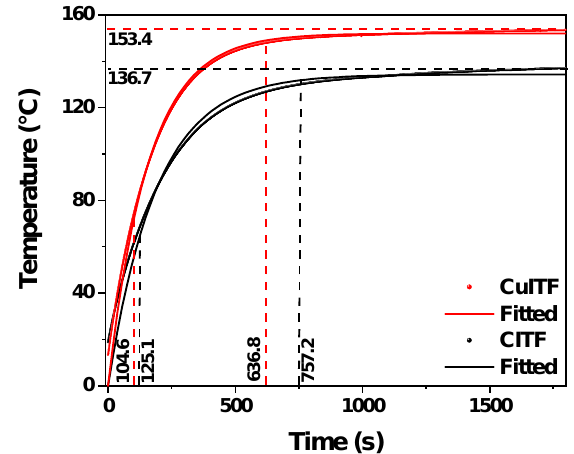
Figure 8. The heating curve settings for CuITF and CITF.